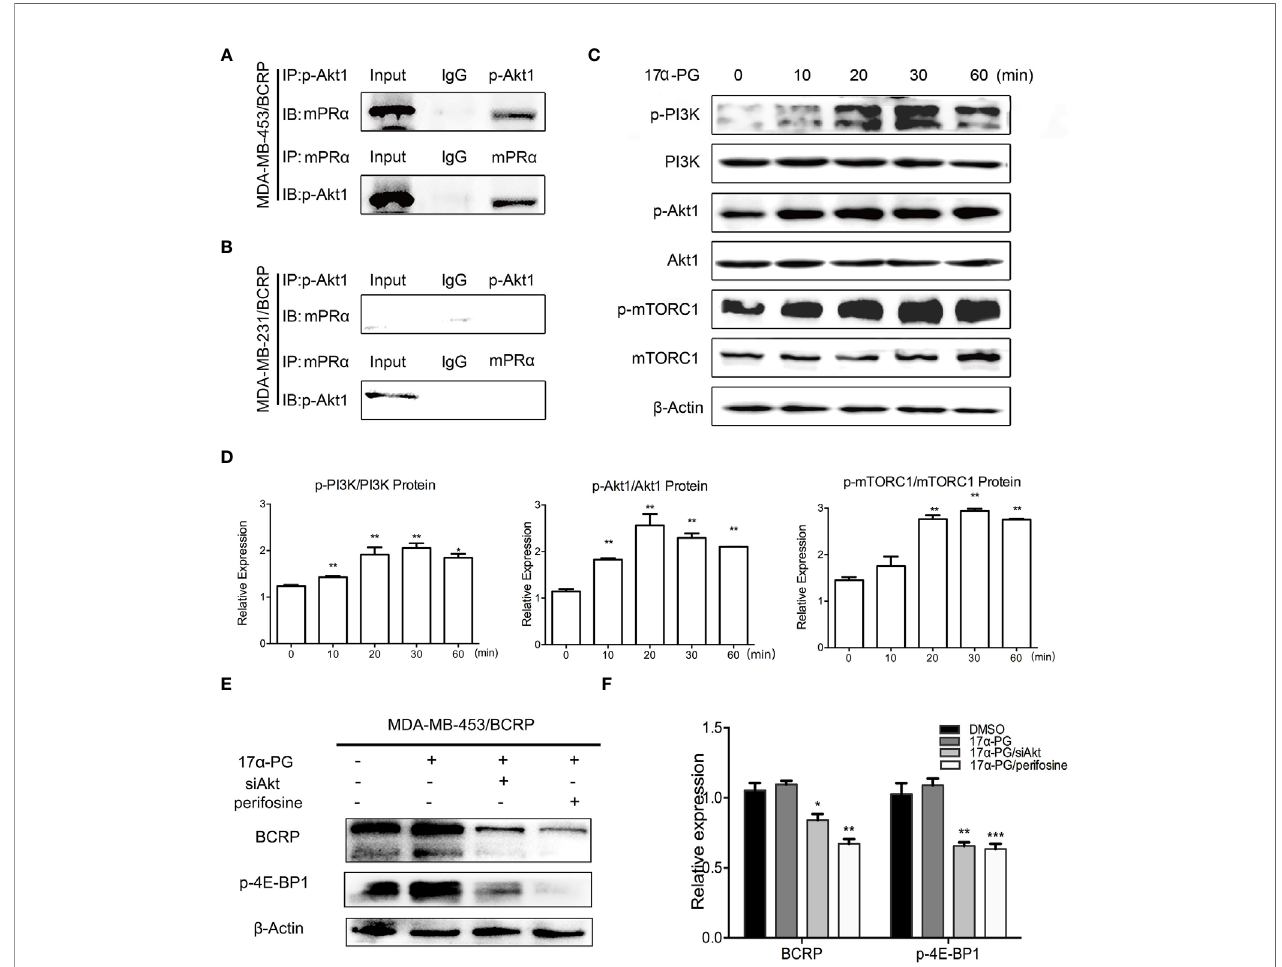
FIGURE 3 | 17 a -PG activated PI3K/Akt/mTOR signaling through the interaction between mPR a and p-Akt1 S473. (A, B) Interaction between mPR a and p-Akt1 S473 in MDA-MB-453/BCRP (A) and MDA-MB-231/BCRP (B) cells. Samples (500 m g) were subjected to CoIP using an anti-mPR a antibody (5 m g) and anti-p-Akt1 antibody (5 m g). Immunoprecipitated lysates were then analyzed by western blotting using anti-p-Akt1 and anti-mPR a antibodies. (C, D) PI3K/Akt/mTOR signaling in response to 17 a -PG in MDA-MB-453/BCRP cells. The cells were starved for 48 h and then treated with 1,000 nM 17 a -PG for 0, 10, 20, 30, and 60 min. Western blotting was performed to check the activation of PI3K, Akt1, and mTOR. (D) The data shown in the histogram are the mean ± SD of three independent experiments. *P < 0.05, **P < 0.01, ***P < 0.001. (E, F) The rescue test of PI3K/Akt/mTOR signaling in response to 17 a -PG in MDA-MB-453/BCRP cells. The cells were starved for 48 h and then treated with 1,000 nM 17 a -PG combined with siAkt or perifosine. Western blotting was performed to check the activation of p-4E- BP1 and expression of BCRP. (F) The data shown in the histogram are the mean ± SD of three independent experiments. *P < 0.05, **P < 0.01, ***P < 0.001.